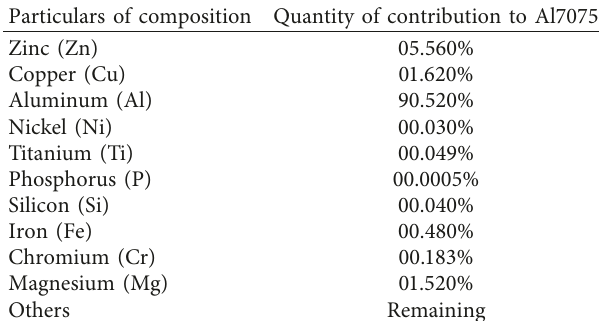
Table 1: Chemical constituents of SiC/Gr/Al7075 nanocomposite.